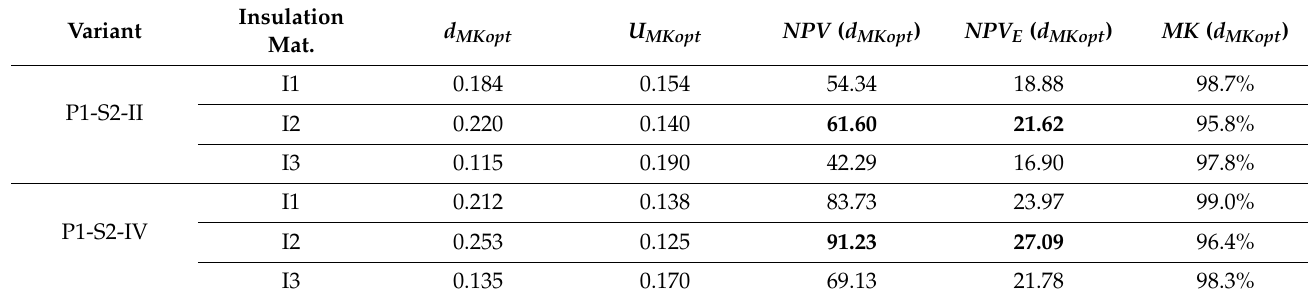
Table 12. Summary of results for Variant P1-S2-II I P1-S2-IV.